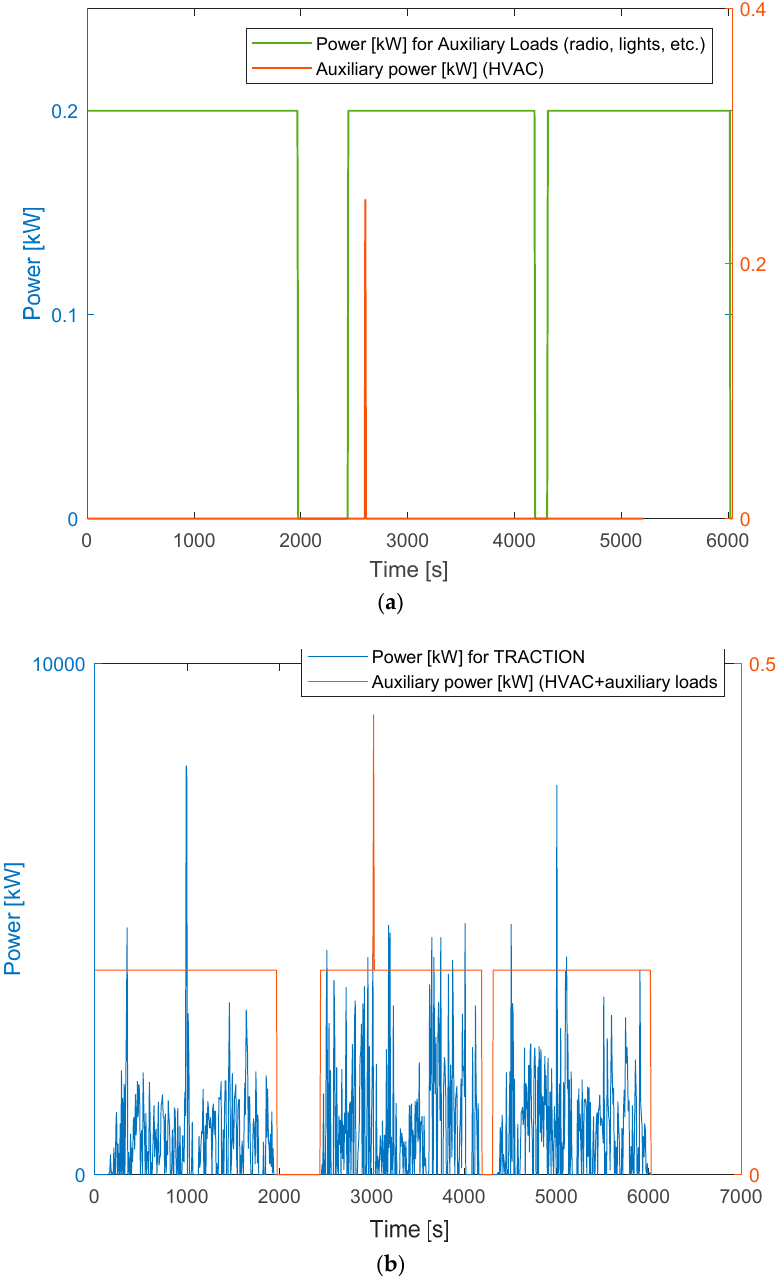
Figure 8. ( a ) Total auxiliary loads ( b ) Traction power and Auxiliary power (in [kW]) for the three consecutive trips.